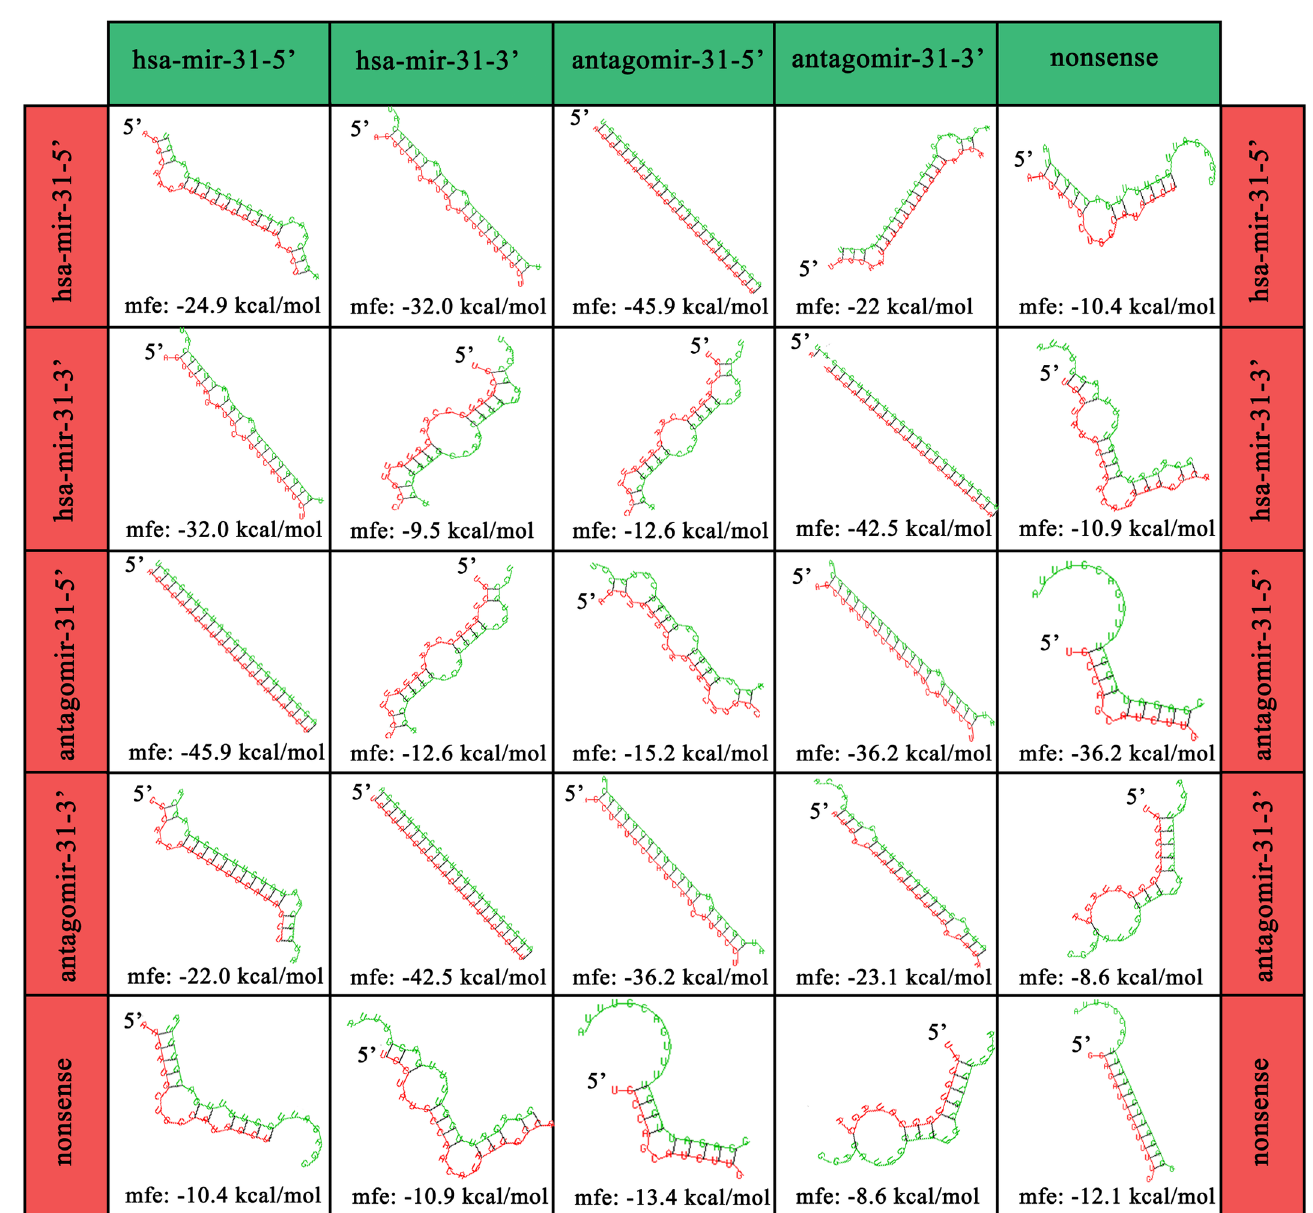
Fig 9. MiRNA binding. Sequence geometries are based on base pairing and minimum free energy using RNAhybrid. The stability of the structure is measured in kcal/mol (i.e. the energy required to break the structure). The greater the energy needed, the more stable the structure. Linearity infers stability, whilst loops indicate incompatibility and lack of binding. The antagomiRs and their corresponding miRNA sequence form the strongest and most stable structure.